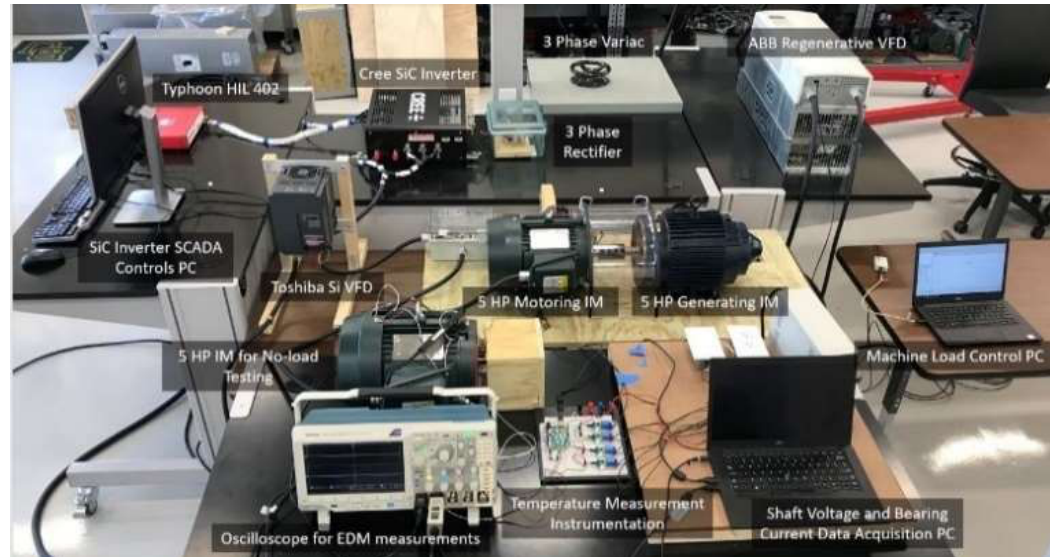
Figure 6. Experimental testbed constructed for the acquisition of shaft voltages and EDM bearing currents for Si- and SiC-based PWM inverters.